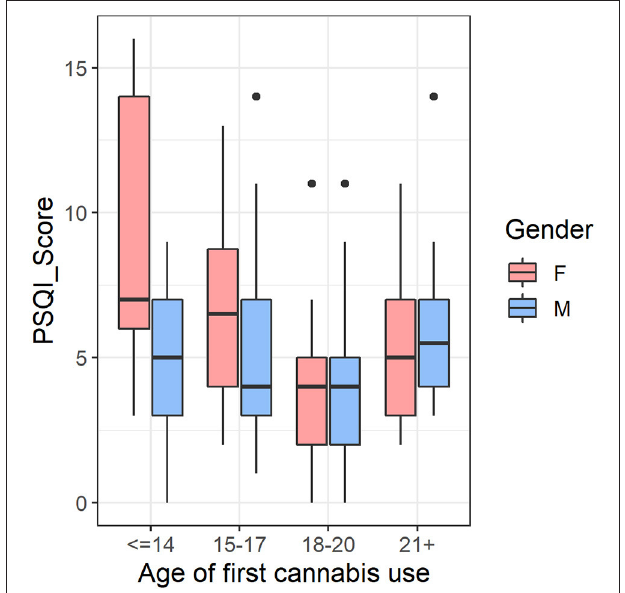
FIGURE 3 | In the cannabis group (CAN) ( n = 170), there was an age of first use-by-sex interaction in self-reported sleep quality, such that females with earlier age of first cannabis use tended to have more self-reported sleep issues, whereas this trend was not present in male cannabis users. We controlled for tobacco usage and total intracranial volume in the analysis. F, Female; M, Male; PSQI, Pittsburgh Sleep Quality Index.